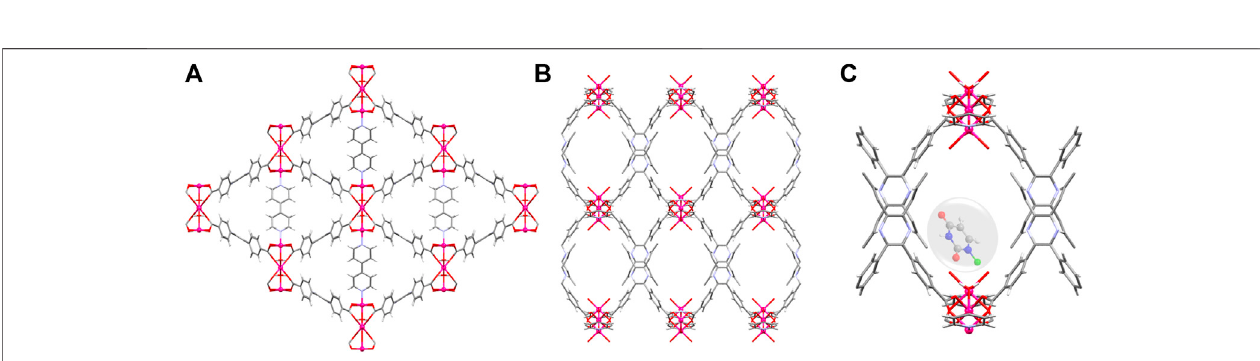
FIGURE 6 | Zn-MOF 5-Fu@1a by (Yan et al., 2020). (A) The one-dimensional triangular channels along b axis with the coordinated bpy ligand. (B) The one-dimensional rhombic channels along the c axis. (C) The 5-Fu molecule ’ s advantageous binding site.